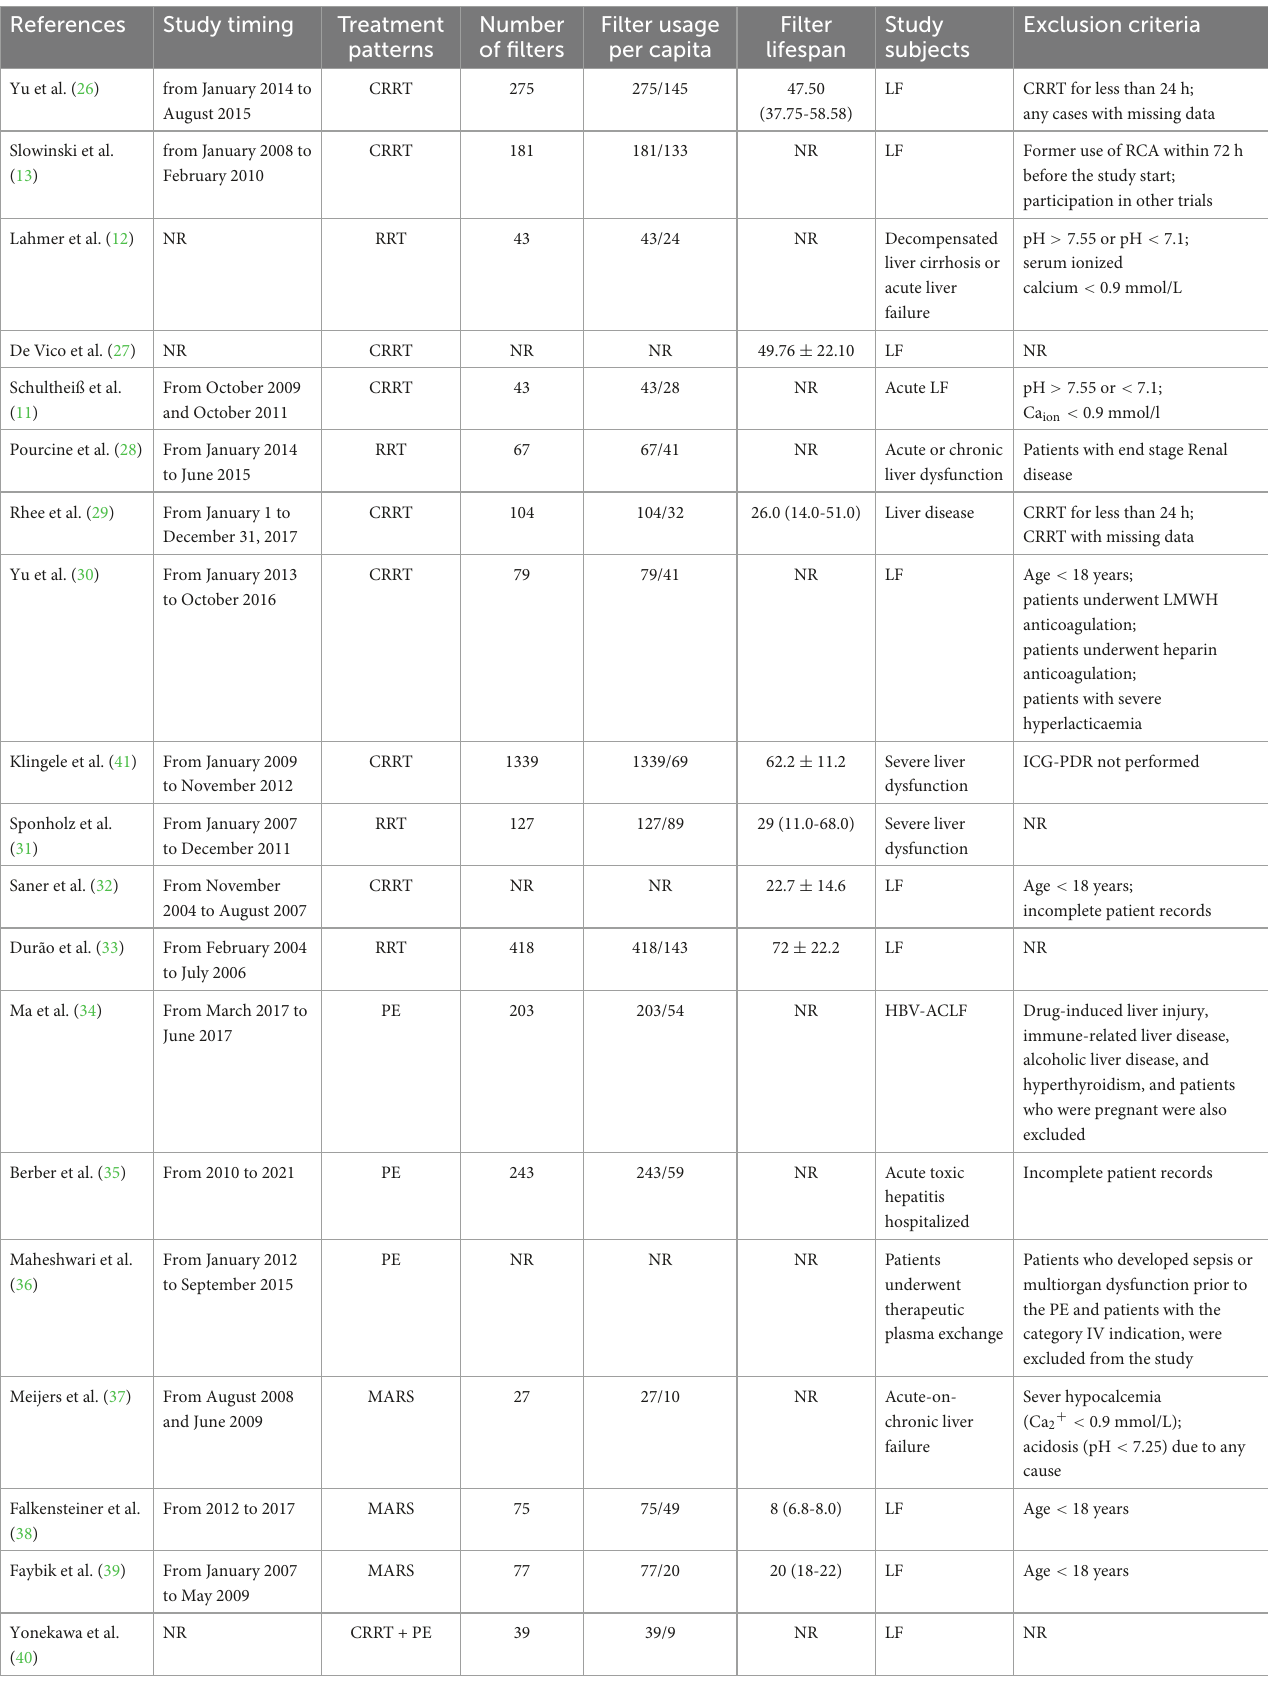
TABLE 3 Characteristics of different treatment